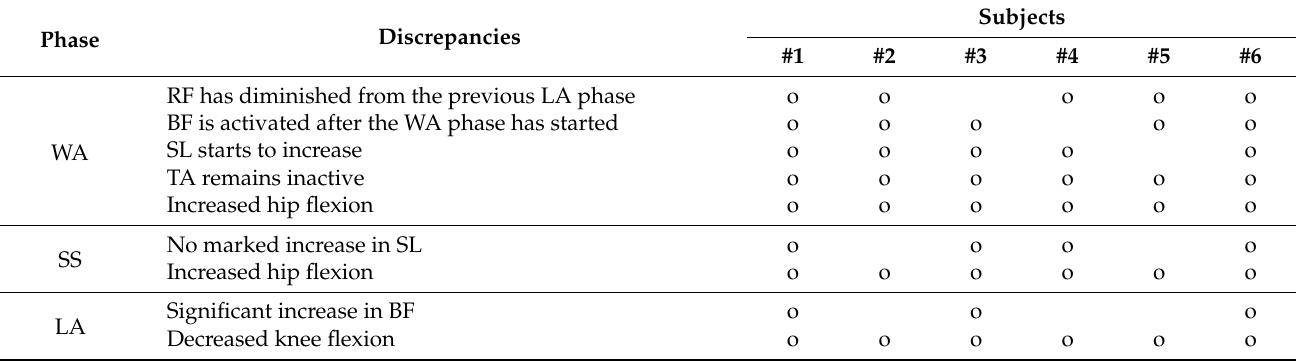
Table 1. Changes in gait patterns due to ReWalk that were commonly observed with crutch gait.